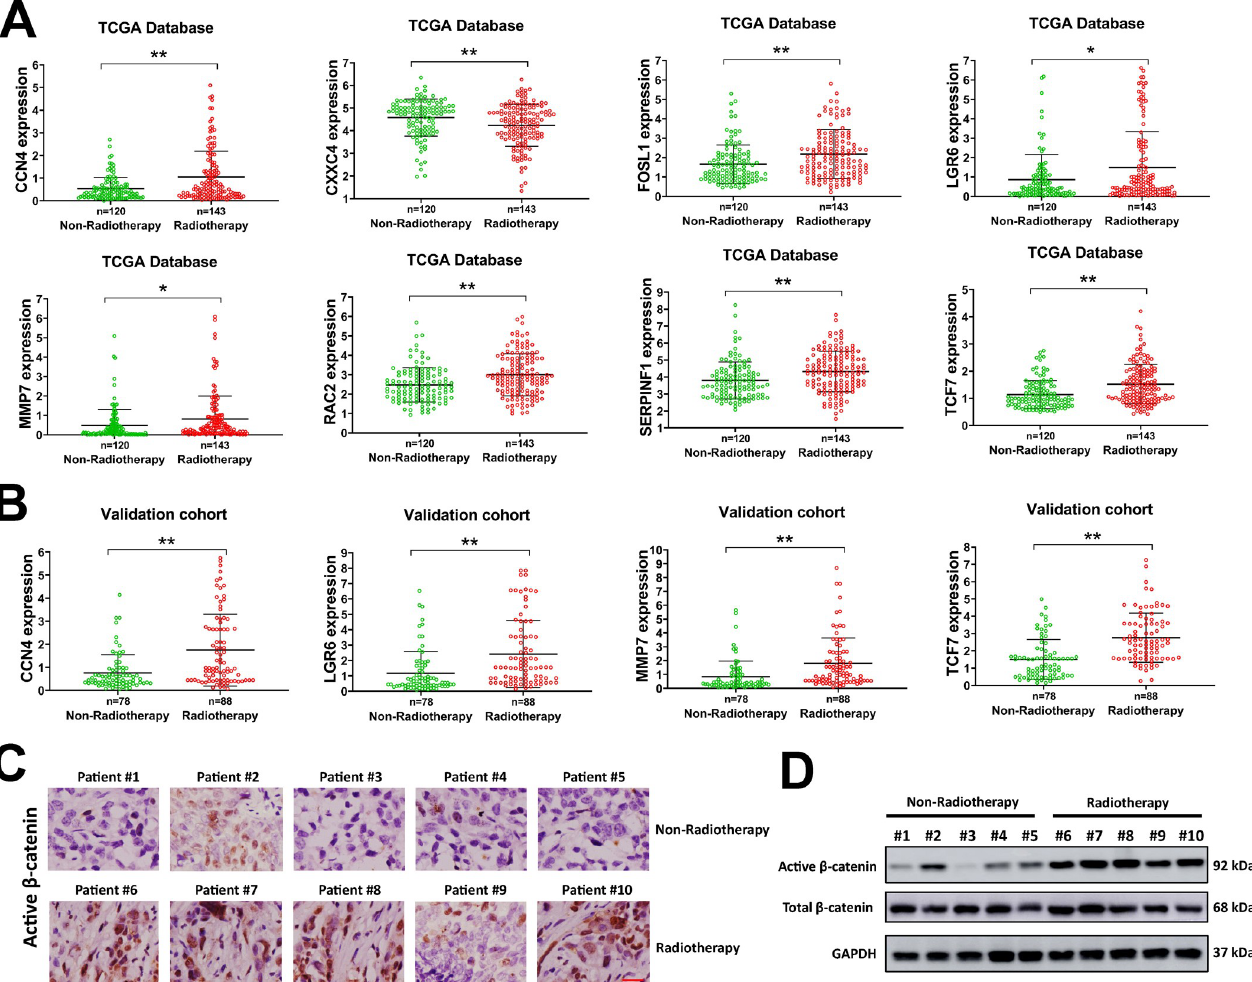
Fig 4. Wnt signaling is activated in radiotherapy treated glioma patients. A, the expression of indicated genes in TCGA database. B, the expression of indicated genes in the Validation cohort of our study. C-D, the expression of active β -catenin in radiotherapy treated and non-radiotherapy treated glioma samples was evaluated by IHC staining (C) or western blot (D). � P < 0.05, �� P <